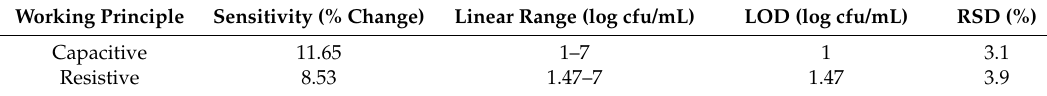
Table 2. Comparison among impedimetric label-free Escherichia coli O157:H7 immunosensors. Schematic Immunosensor Assembly